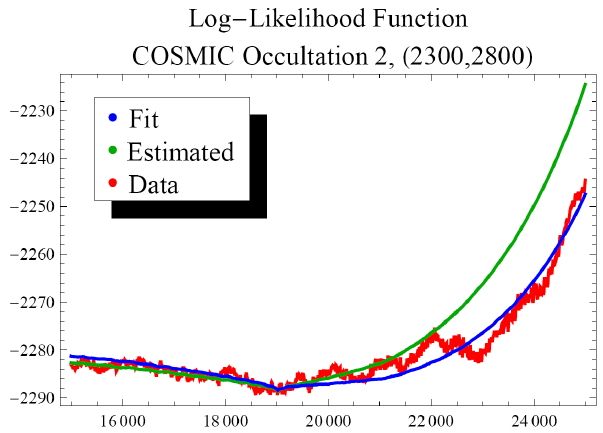
Fig. 24. Log-likelihood functions, as a function of η 1 in km, from data (red), estimated parameters (green), and fitted parame- ters (blue) for occultation 1.